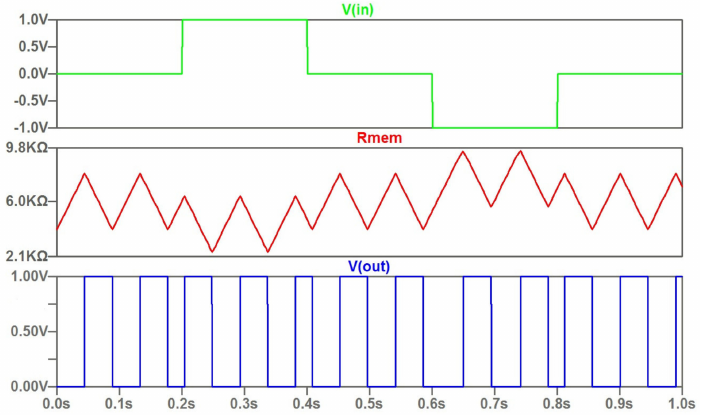
Figure 4. The computed waveforms of the memristor-based oscillator with controlled thresh- old parameters.